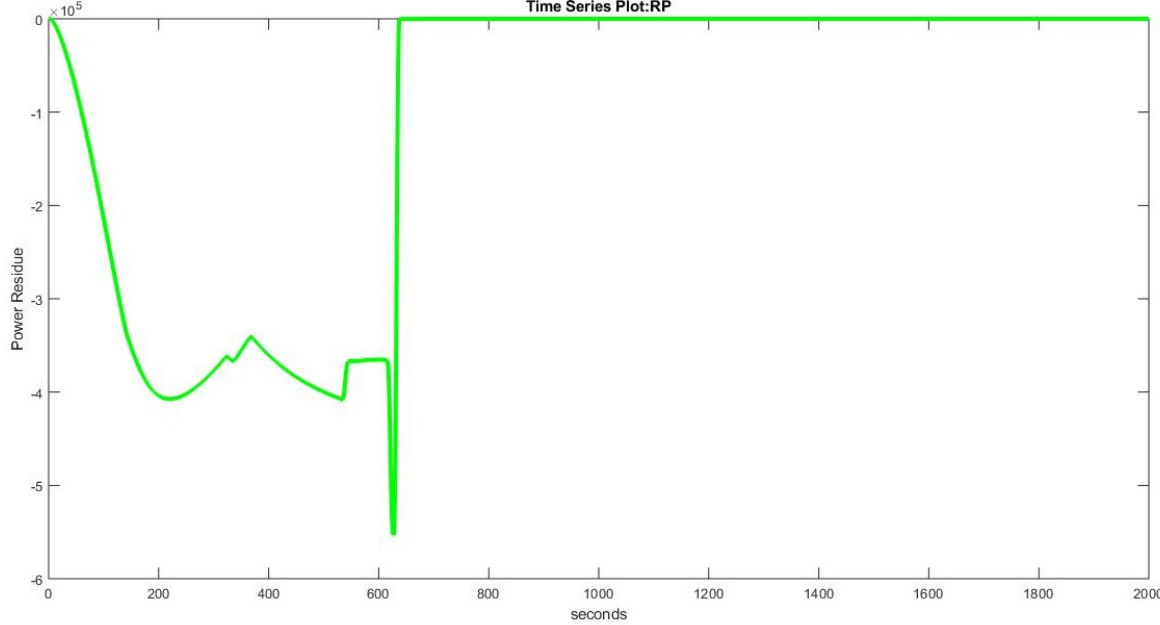
Figure 10. Power residue for the saturation fault of sluice gate w 1 .